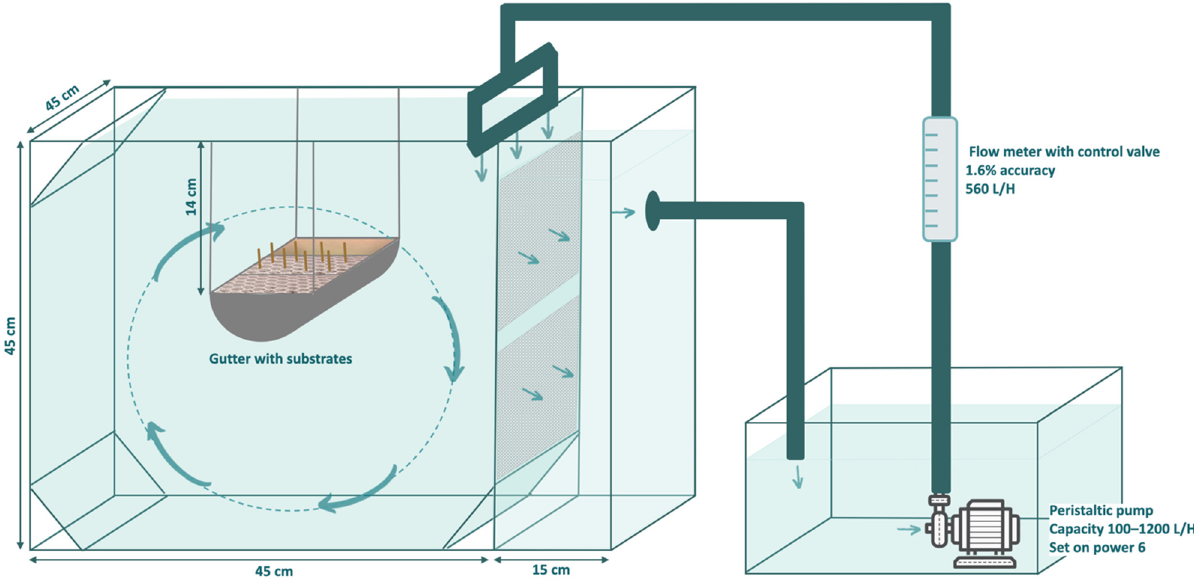
Figure 1. Illustration of the experimental design (larvae settlement experiment) and its components. The arrows represent the direction of water flow.